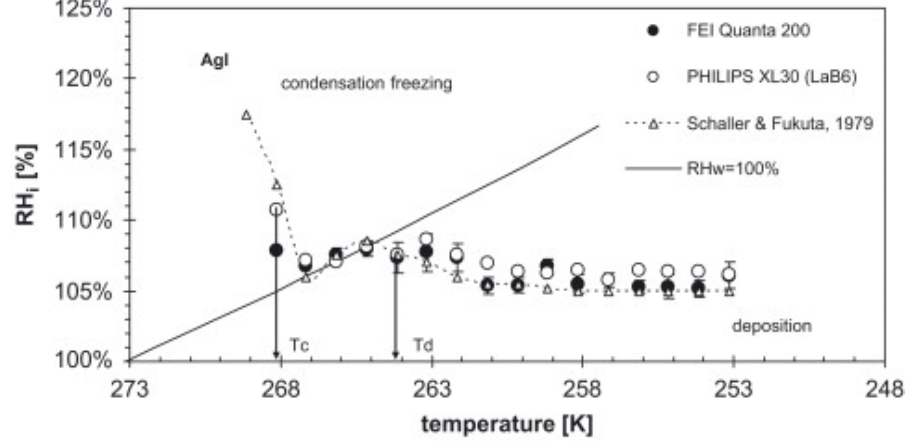
Figure 3. Supersaturation vs. temperature diagram for silver iodide.